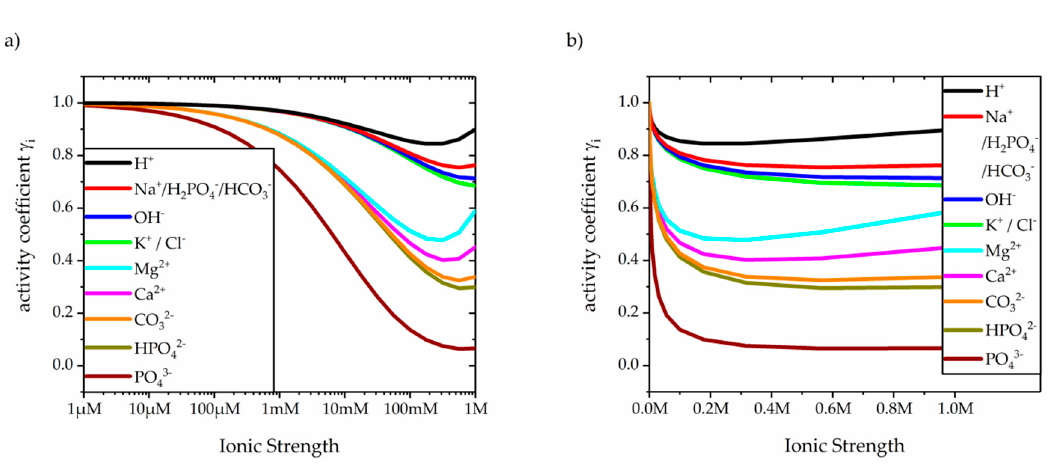
Figure 1. The calculated activity coe ffi cients for the main inorganic ions present in mitochondria, ( a ) in logarithmic scale and ( b ) in linear scale.